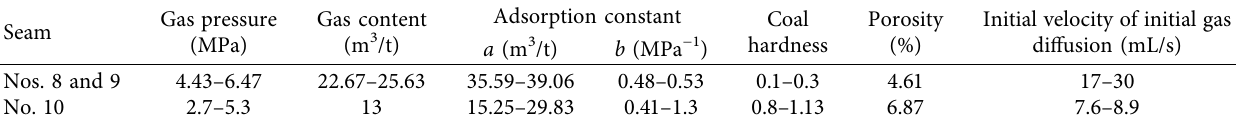
Table 4: Gas parameters of no. 8, no. 9, and no. 10 coal seams in III1 mining area.